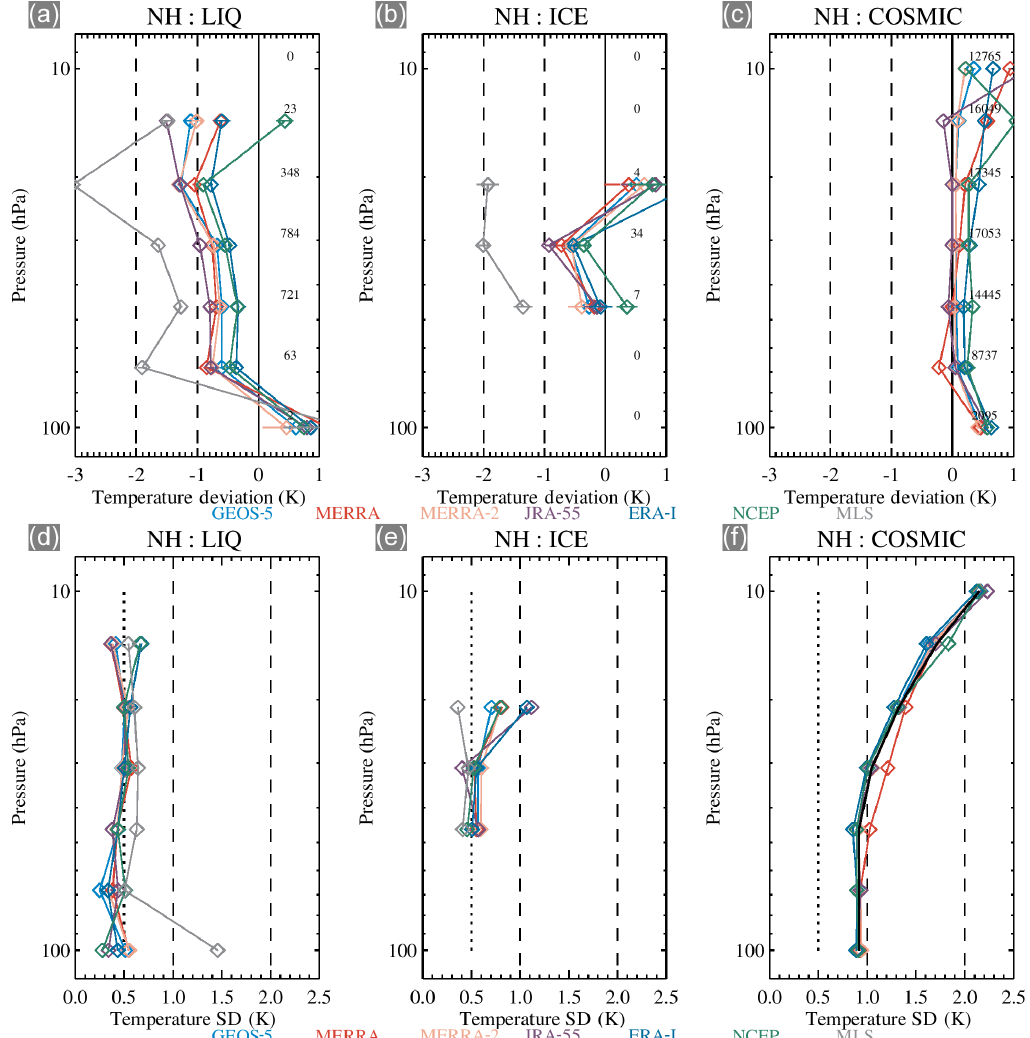
Figure 17. The same as for Fig. 16 except for the Arctic PSC seasons (2 December (d336) to 31 March (d090) from 2008/2009 to 2012/2013).